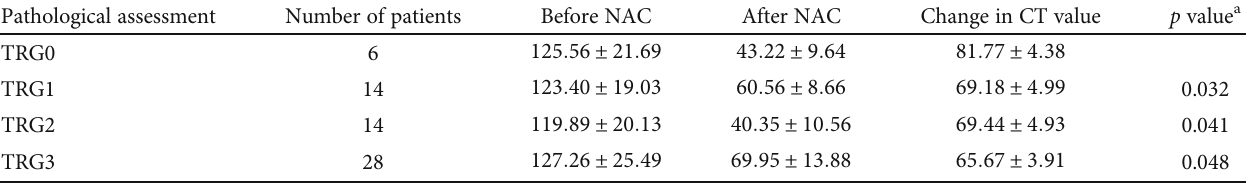
Table 5: Comparison of imaging and pathological assessments of NAC e ff ectiveness for